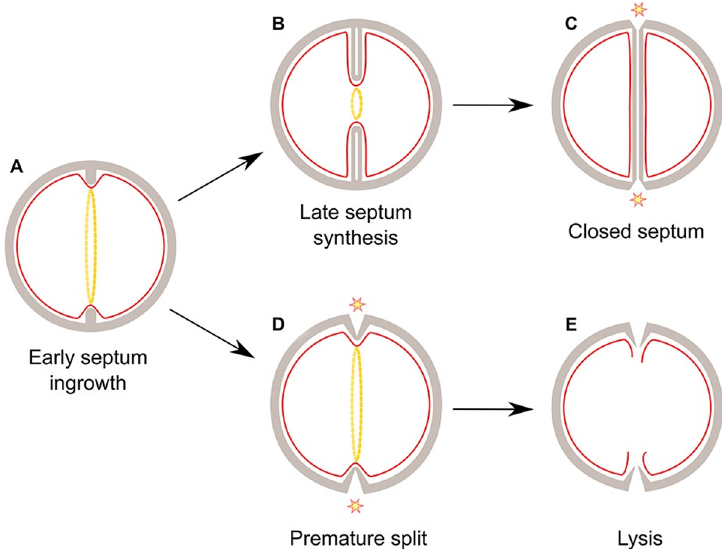
Fig 8. Model of temperature dependent lysis of S . aureus clpX mutant. At 37˚C (upper panel), progression from an early (A) to a late septal ingrowth (B) occurs in the absence of ClpX activity. Upon septum closure, release of cross- linking substrates from the TP domain of PBPs in combination with teichoic acid biosynthesis serve as signals to activate autolytic splitting of daughter cells ( C ). At 30˚C (lower panel), progression from an early to a late septal ingrowth becomes more dependent on assistance from the ClpX chaperone, and in the absence of ClpX, septum synthesis occasionally stalls in an early septal ingrowth that put the cells at risk for activation of Sle1- mediated autolytic splitting from the peripheral wall ( D ). Cells with premature splitting will be prone to lysis due to the risk of turgor pressure forces breaking the thin and mechanically weak cell wall at the tip of the ingrowing septum ( E ).